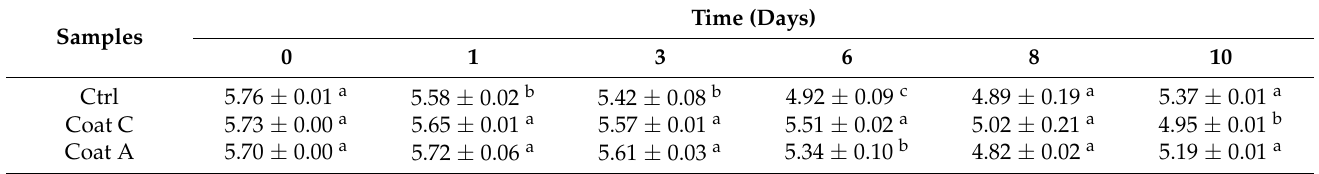
Table 3. The pH in coated and uncoated prickly pears during storage at 4 ◦